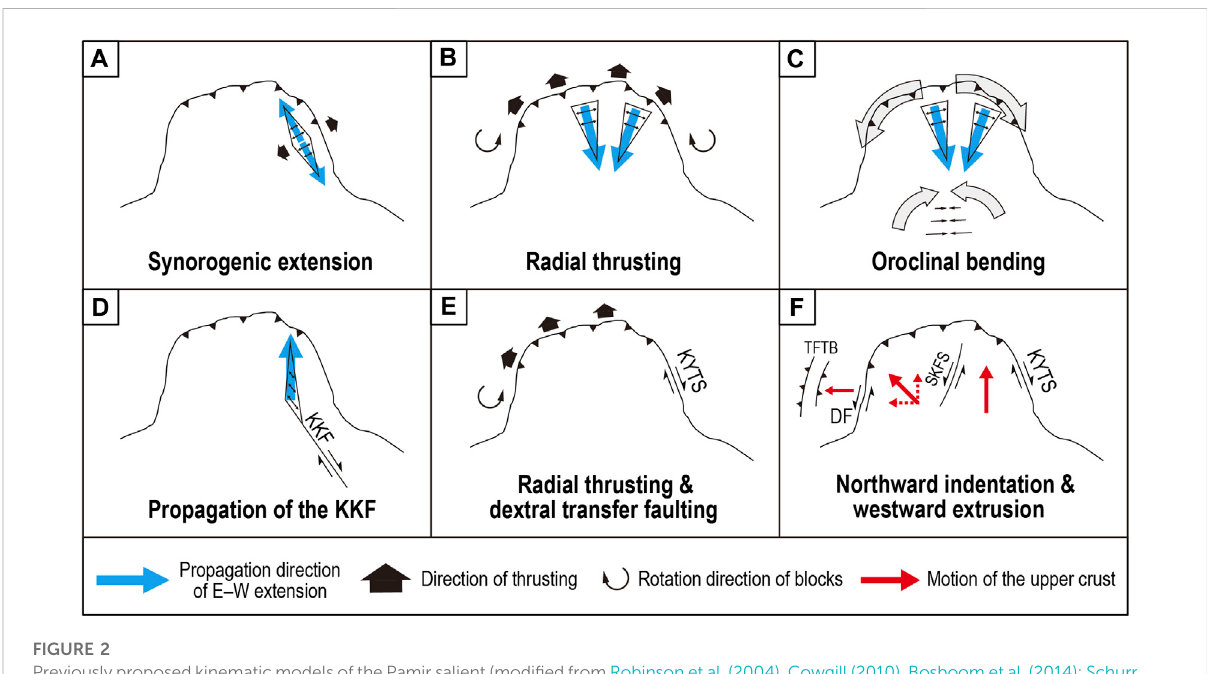
FIGURE 2 Previously proposed kinematicmodelsofthePamirsalient(modi fi edfromRobinsonetal. (2004), Cowgill (2010),Bosboom etal. (2014);Schurr et al. (2014)). See detailed description of these models in the text. Fault names same as Figure